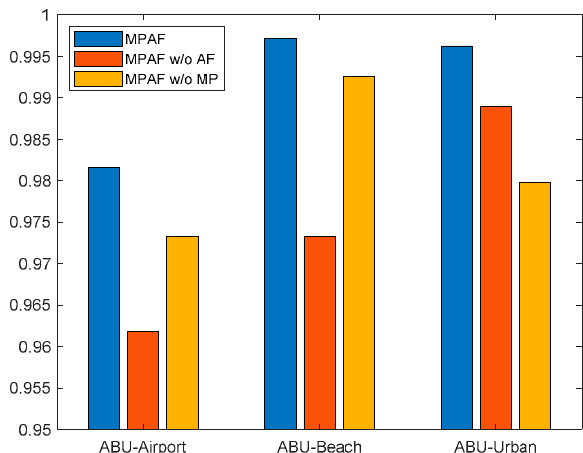
Figure 16. Average AUCs of ROC for MPAF, MPAF without attribute filter (AF) step, and MPAF without morphological profile (MP) step on the ABU datasets.